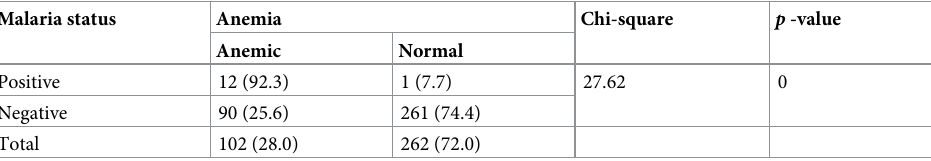
Table 3. Association between asymptomatic Plasmodium infection and anemia among study participants. Malaria